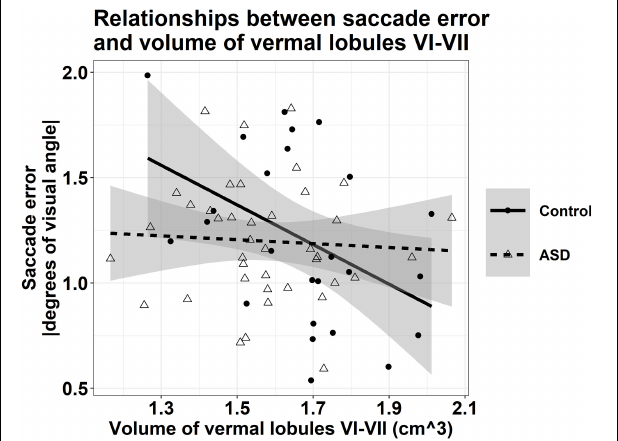
FIGURE 5 | Relationship between the volume of vermal lobules VI-VII and saccade error, averaged across target direction and amplitude. Greater volumes of vermal lobules VI-VII were associated with reduced saccade error in TD controls ( r = –0.438, p = 0.007), but not individuals with ASD ( r = –0.060, p = 0.671). Shaded regions reflect the 95% confidence interval of a group-level linear fit.